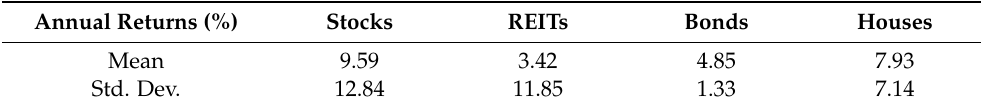
Table 1. Annual price returns and standard deviations of various investment vehicles in New Zealand, 2002–2018.